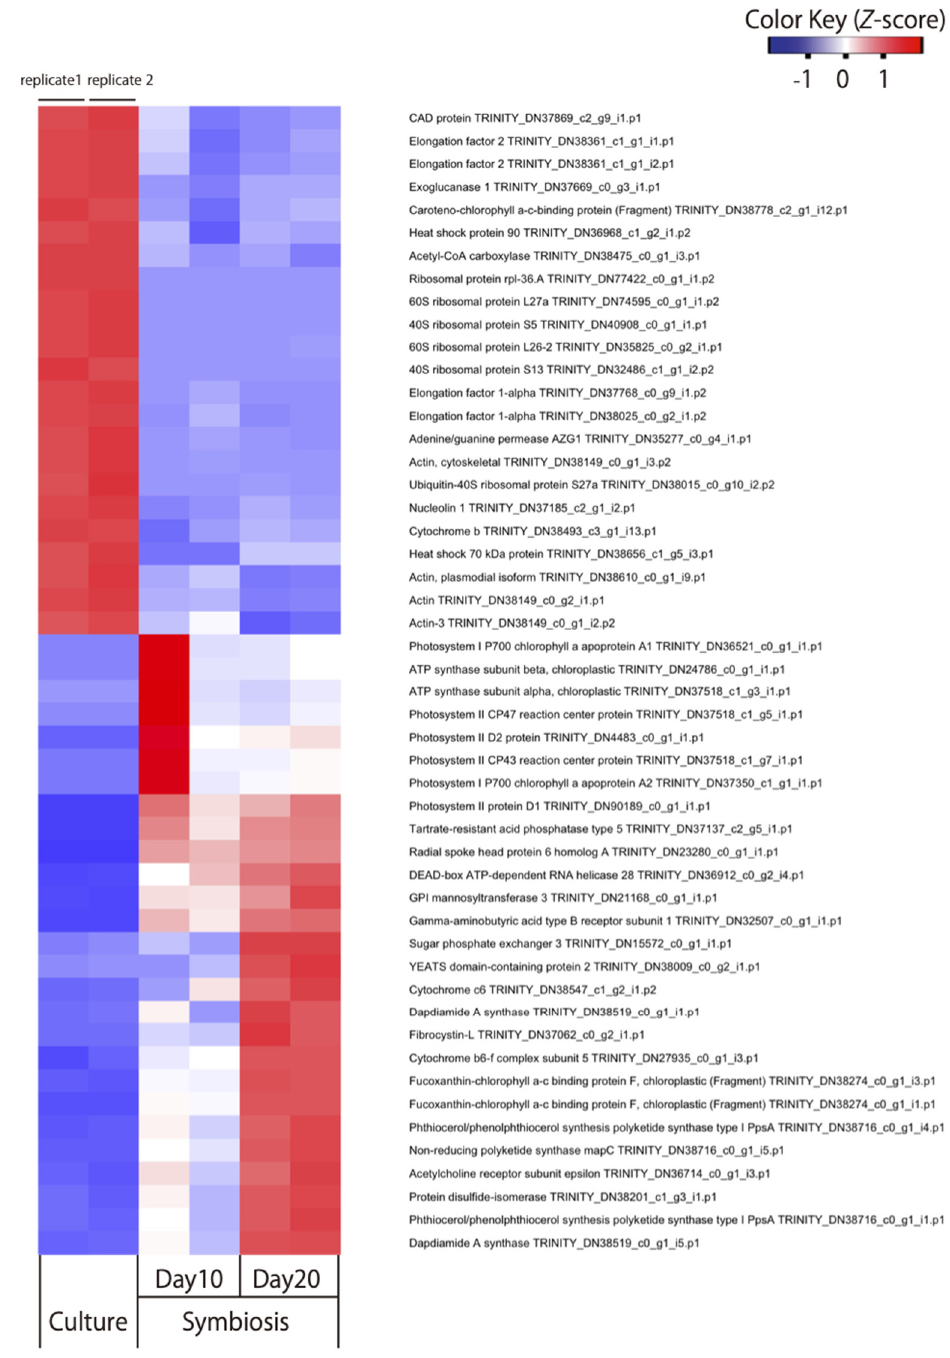
Figure 1. Heat map of RNA-seq analysis for 50 selected genes showing different gene expression pattern in free-living and symbiotic Durusdinium at 10 and 20 days post-inoculation ( n = 2). Among the 1214 DEGs shown in Figure S1, the 50 genes with the lowest false discovery rate are summarized in the heatmap.